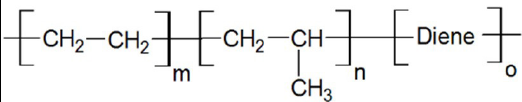
Figure 1. Chemical structure of EPDM rubber.